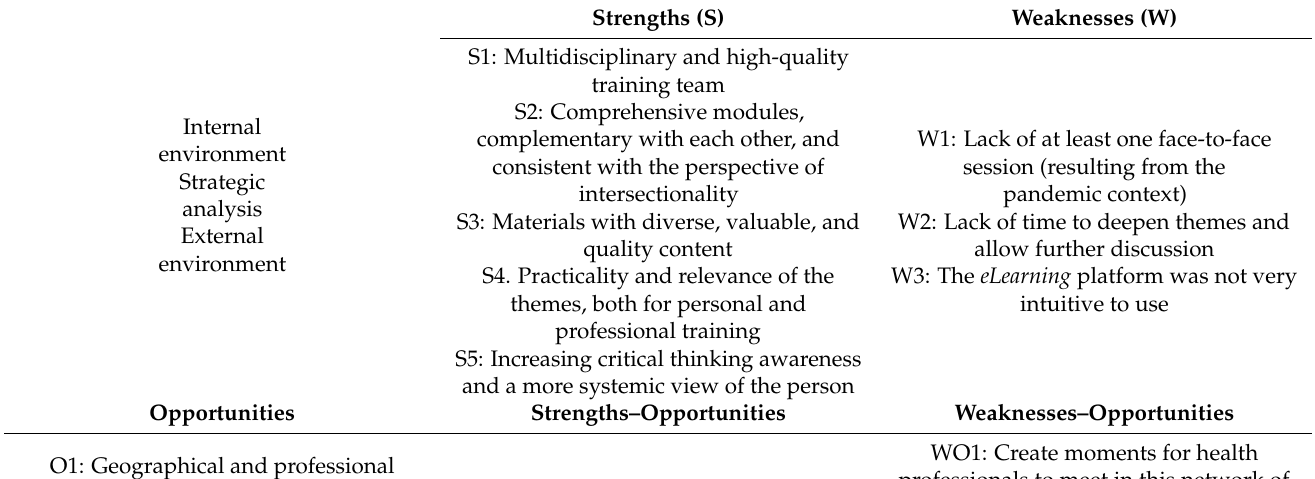
Table 2. Strategic analysis of the “Health in Equality”